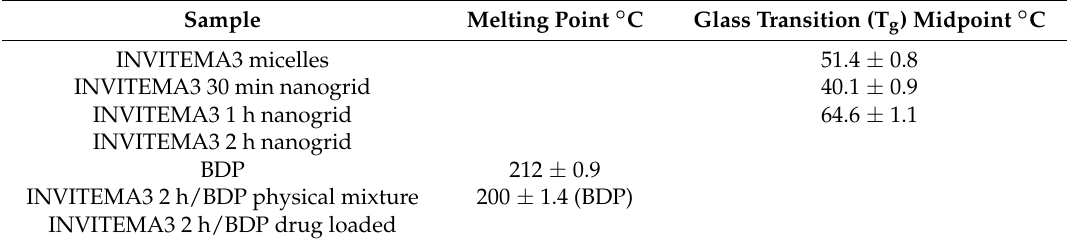
Table 2. Thermal behaviors of INVITEMA micelles, nanogrids (30 min, 1 and 2 h represent the different UV irradiation time), drug loaded micelles or nanogrids, beclomethasone dipropionate (BDP) and INVITEMA3/BDP physical mixture, n = 3.